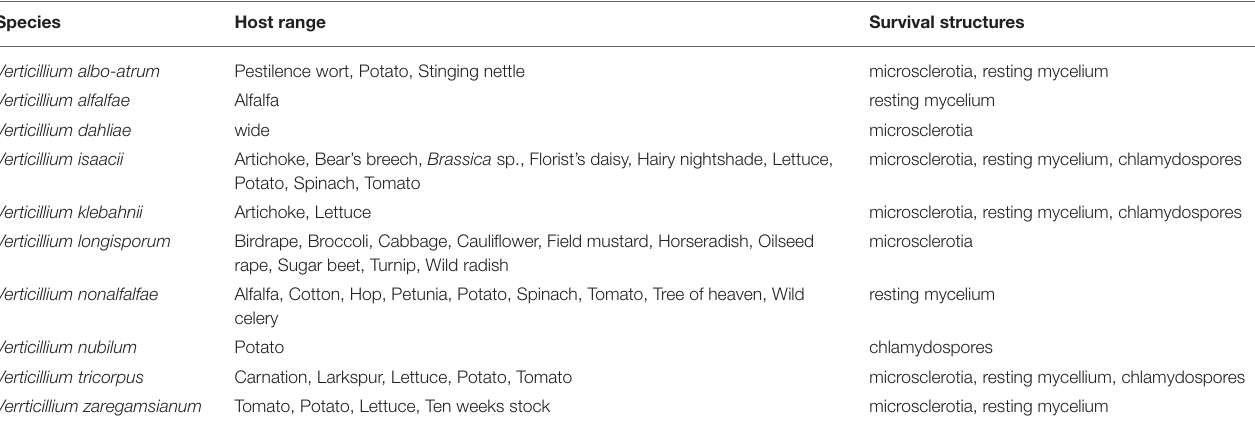
TABLE 1 | Species within Verticillium with their host range and survival